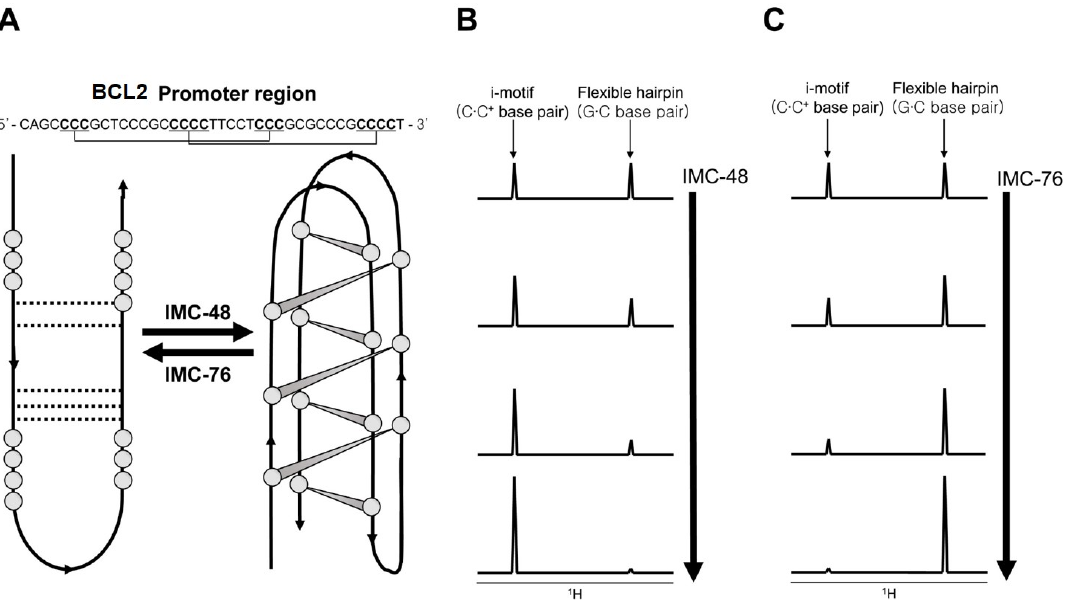
Figure 5. ( A ) The structural conversion from monomeric to dimeric BCL2 C-rich strand induced by ligands. Cytidines participating in C · C + base-pairs for i-motif formation are marked in bold. ( B,C ) Schematic drawing of 1 H imino proton peak of BCL2 C-rich strand changed by ligand titration.